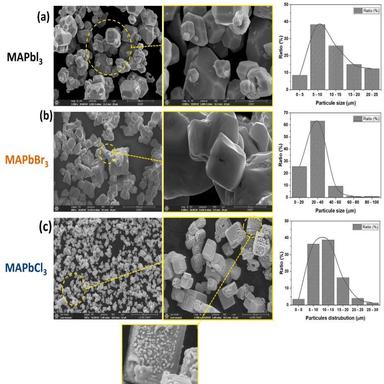
Top-view SEM images of powder perovskites and their particle size distribution: a) MAPbI3, b) MAPbBr3 and c) MAPbCl3.